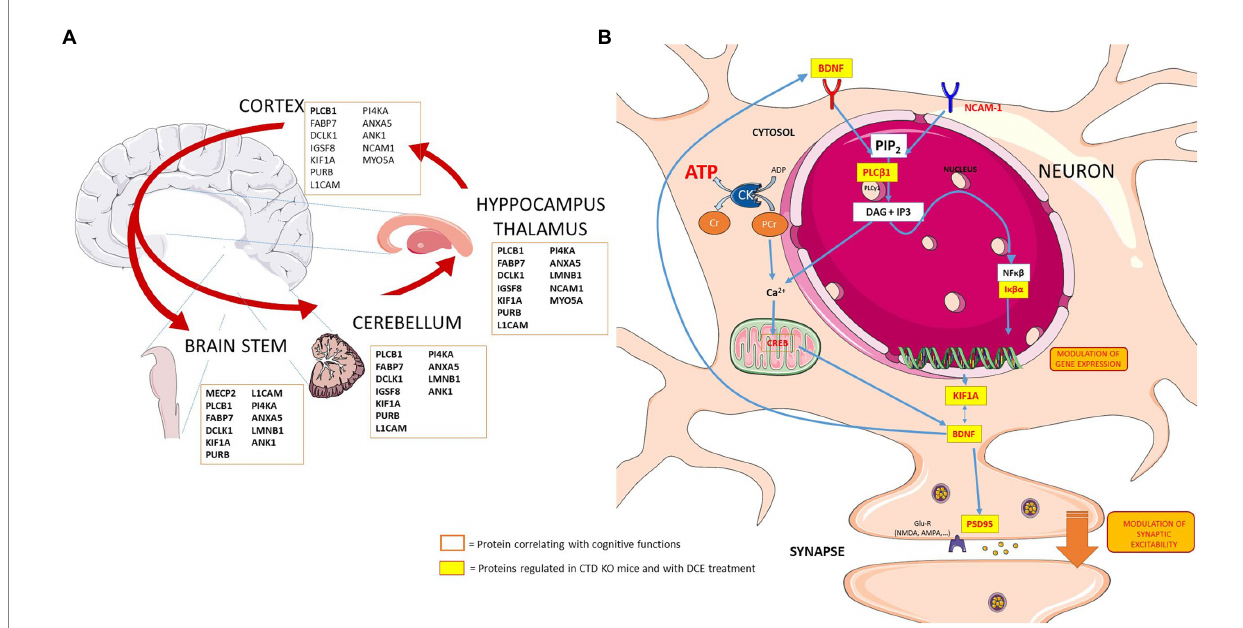
FIGURE 5 Schematic presentation showing the key players in the different brain regions and potential links between several proteins that are regulated in neurons in the context of CTD and by DCE treatment. (A) Proteins regulated by DCE in CrT KO mice. (B) DCE mediated the abundance of PLCB1. DCE- mediated upregulation of PLCB1 levels in the brain might lead to the production of inositol-1,4,5-triphosphate (IP3), and IP3 modulates the NF- κβ pathway via dysregulation of a PKC α inhibitor, I κ B α , thereby altering the expression of NF- κβ -inducible genes which regulates the NF- κβ pathway by rescuing I κ B α protein levels in CrT KO mice. NF- κβ is bound by I κ B α and then translocates to the nucleus to activate target genes including KIF1A and